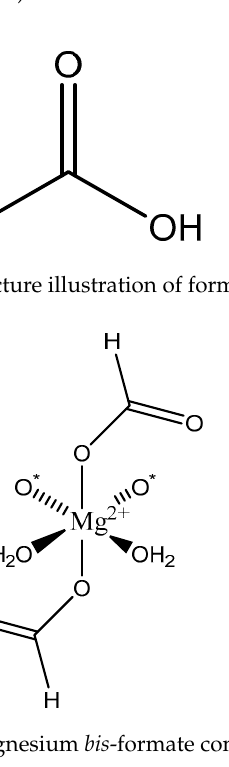
Figure 8. Structural illustration of the magnesium anthranilate structure proposed by Schmidbaur et al. [89]. The structure is devoid of two interstitial waters.